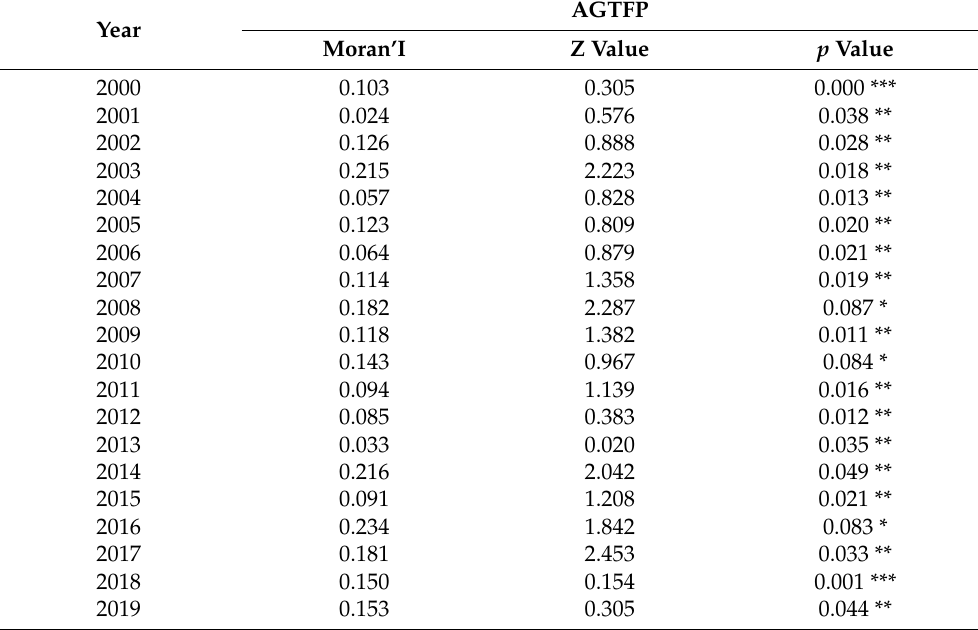
Table 4. Global correlation test results of AGTFP in